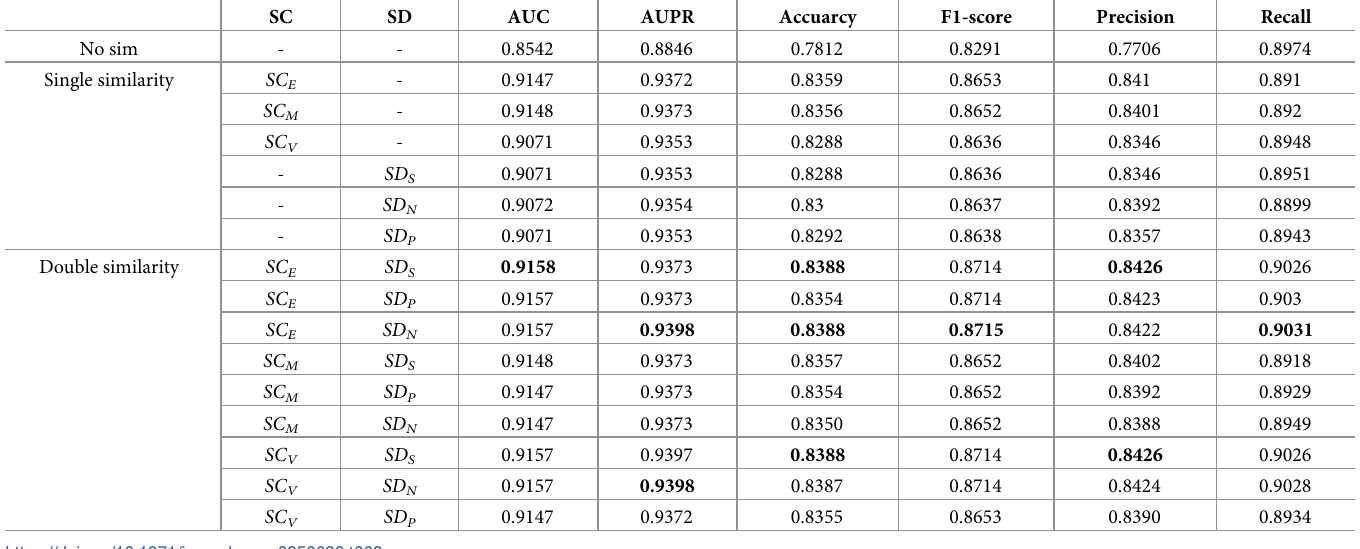
Table 2. The performance of CDSML on GDSC dataset using different scenarios including double similarity, single similarity, and no similarity. The best value of each criterion is shown in bold.